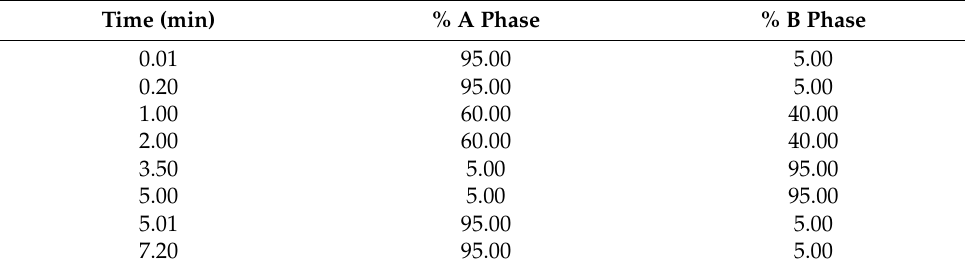
Table 1. Gradient elution program—mobile phase